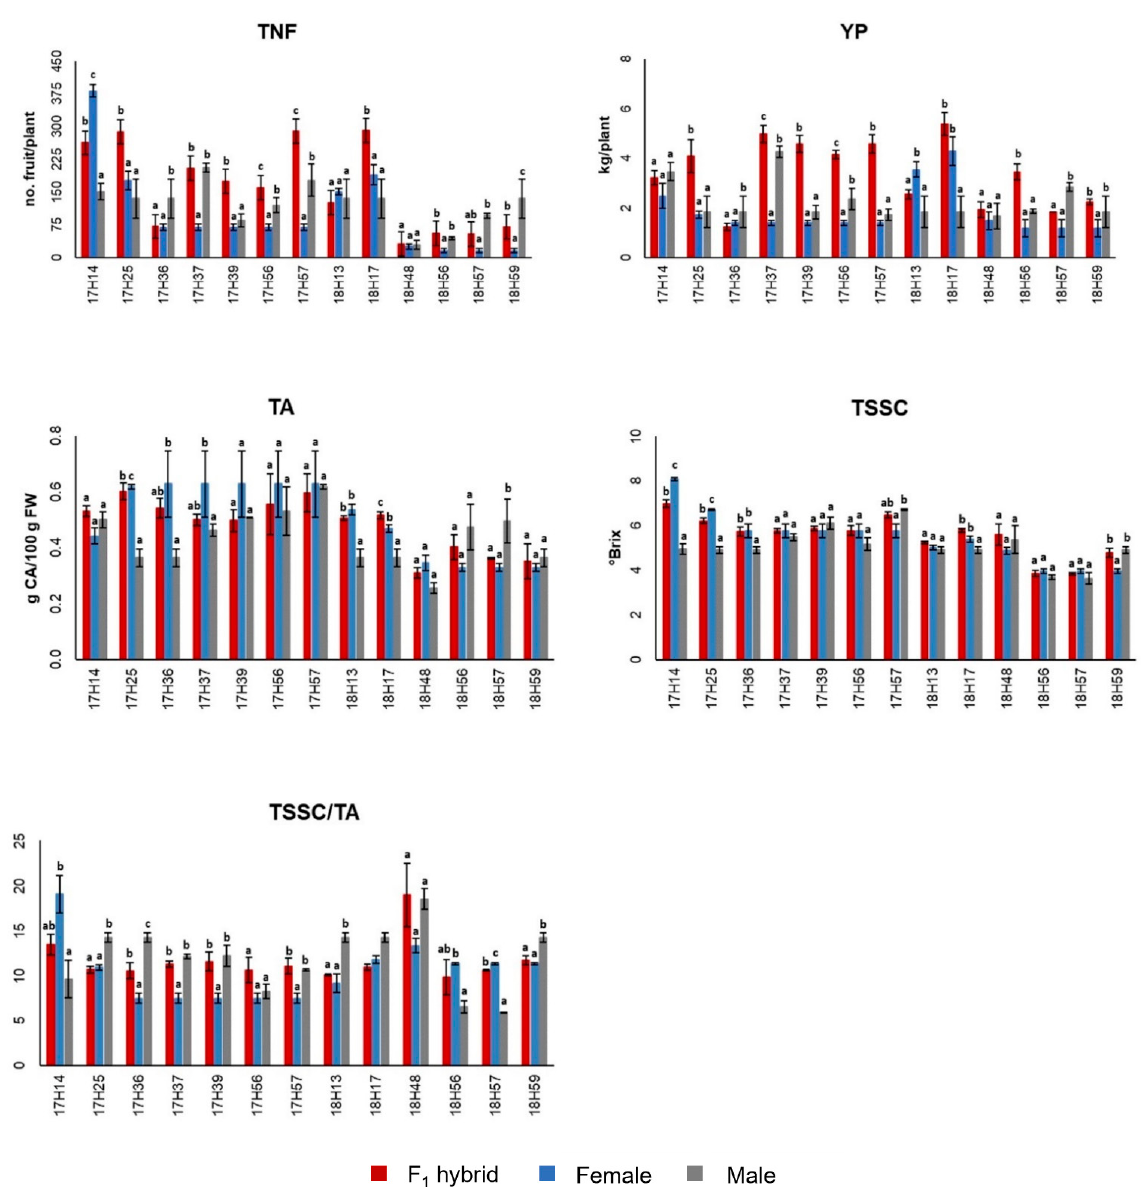
Figure 3. Comparisons among the F 1 hybrids and their parents by Duncan’s t-test (a, b, c, groups of significance). TNF, number of fruit per plant, YP yield per plant, TSSC, total soluble solid content, TA, titratable acidity and TSSC/TA ratio, FW, fruit weight.